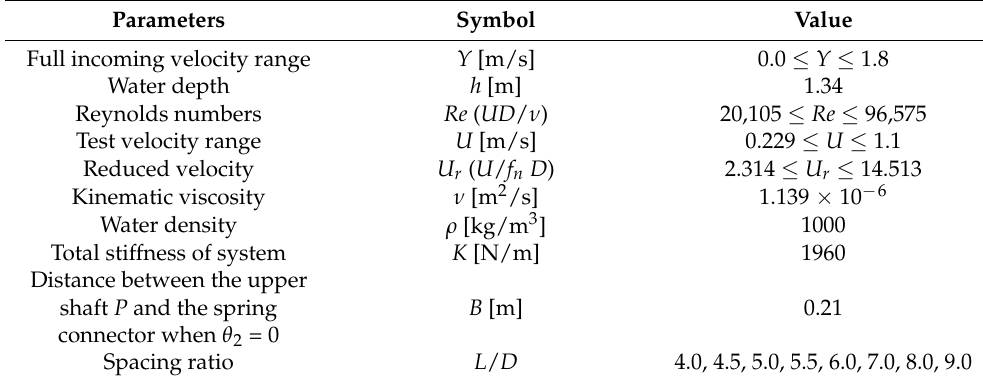
Figure 5. Plan view schematic of the recirculating water tunnel. The relevant parameters of the FIR experiment are shown in Table 1. Table 1. Test parameters.